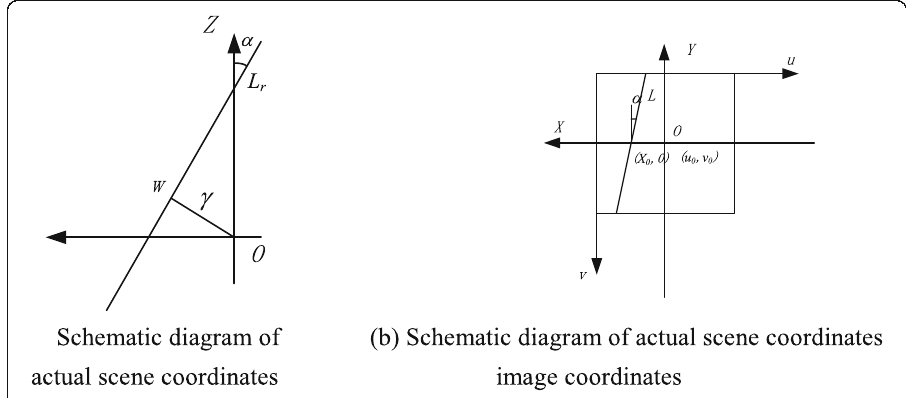
Fig. 8 Coordinate system of agricultural robots. a Schematic diagram of actual scene coordinates. b Schematic diagram of actual scene coordinates ’ image